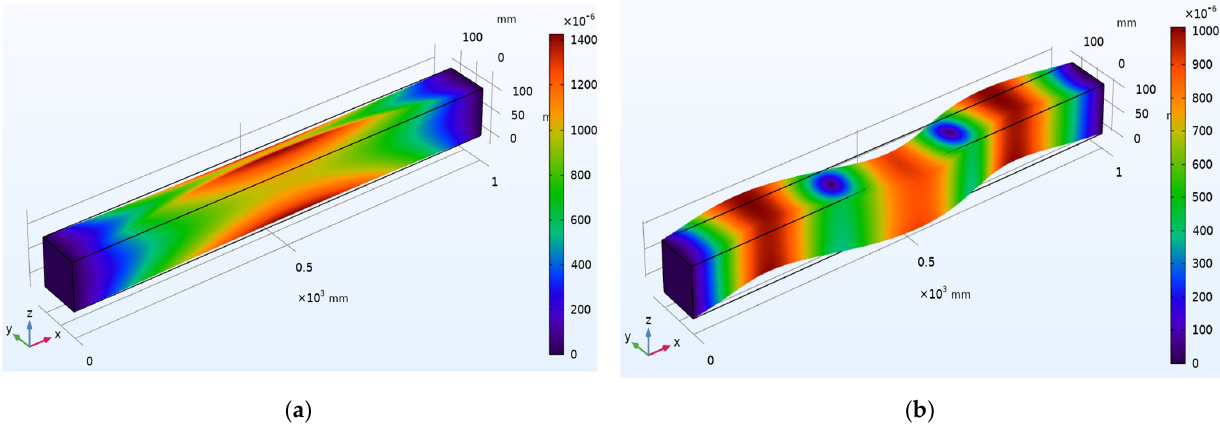
Figure 5. Surface displacement contours of beam for torsional mode shapes: ( a ) First mode; ( b ) Sec- Figure 5. Surfacedisplacementcontoursofbeamfortorsionalmodeshapes: ( a )Firstmode; ( b ond mode.